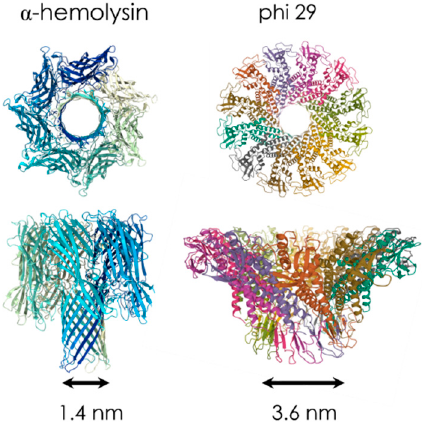
Figure 2. α -hemolysin ( α -HL) nanopore structure (PDB: 7AHL) and phi29 motor nanopore structure (PDB: